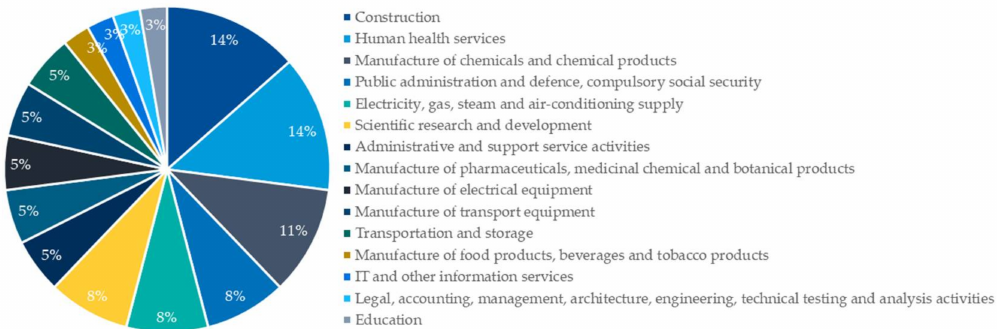
Figure 5. Distribution of respondents’ industries ( n = 37).